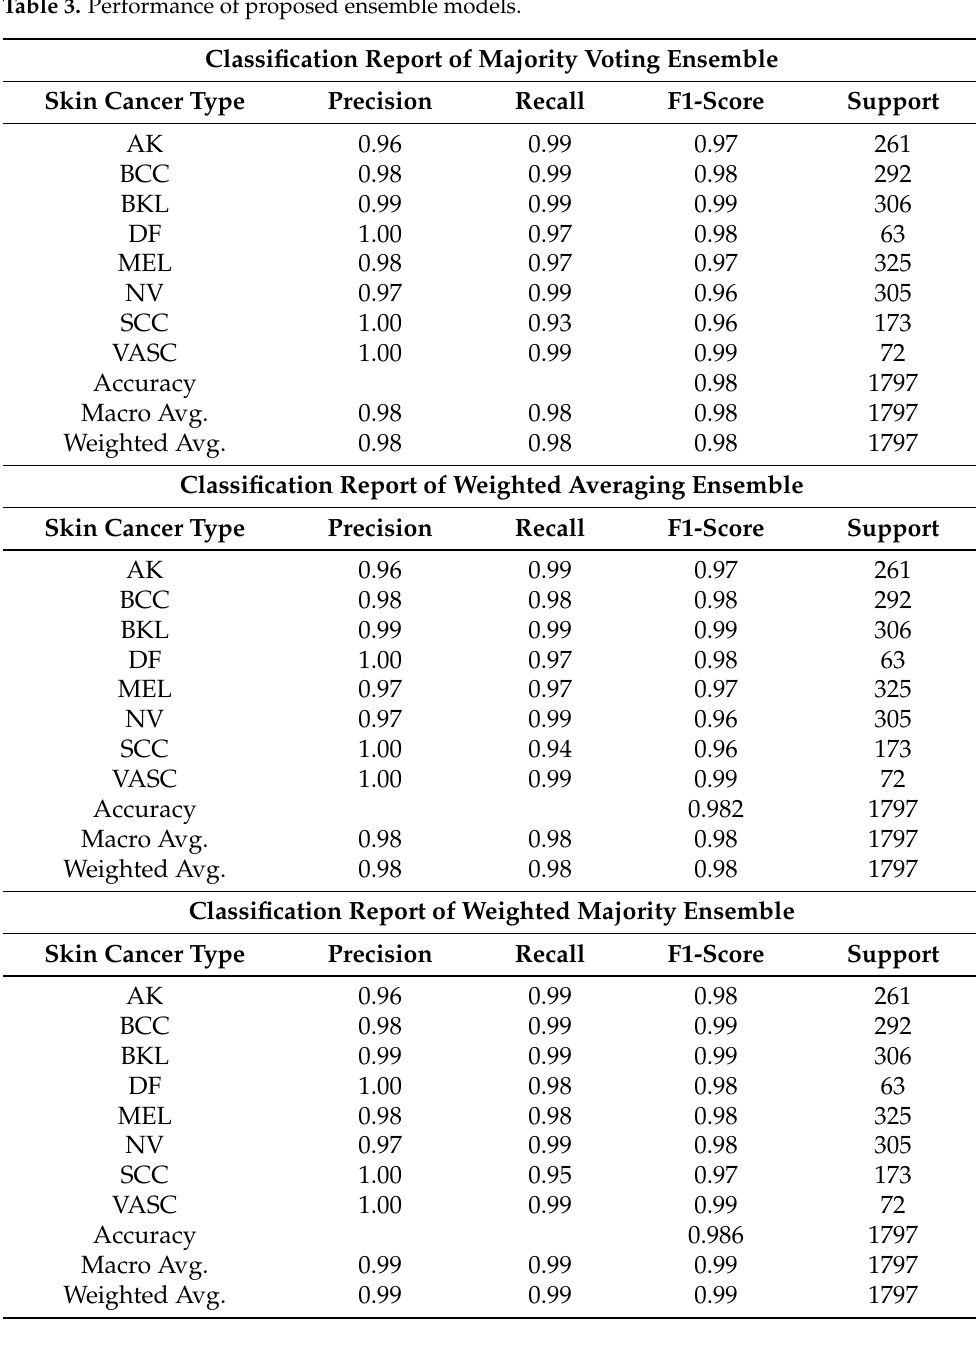
Table 3. Performance of proposed ensemble